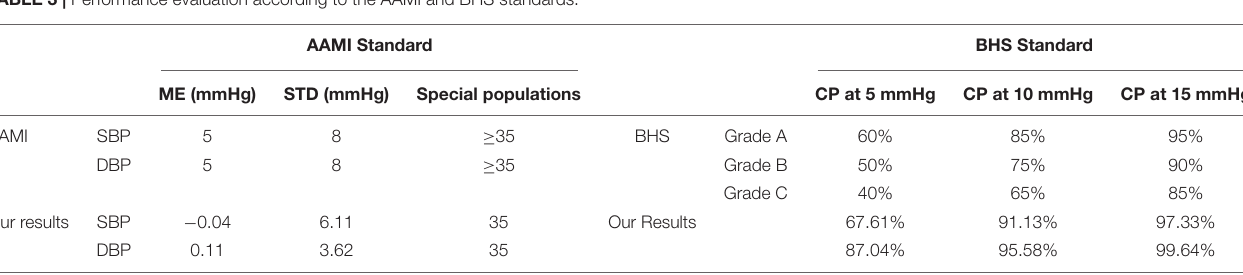
FIGURE 4 | (A) Performance (mean value ± standard deviation of RMSEs) of different regression algorithms to estimate SBP and DBP in the validation set of all patients. Triple asterisks “*,” “**,” and “ns” indicate statistical significance at p < 0.05, p < 0.01, and p > 0.05, respectively. (B) Estimated beat-to-beat SBP and DBP comparisons in a representative patient, with the proposed method indicated in red and the reference shown in black. Abbreviations show in Figure 3 . TABLE 3 | Performance evaluation according to the AAMI and BHS